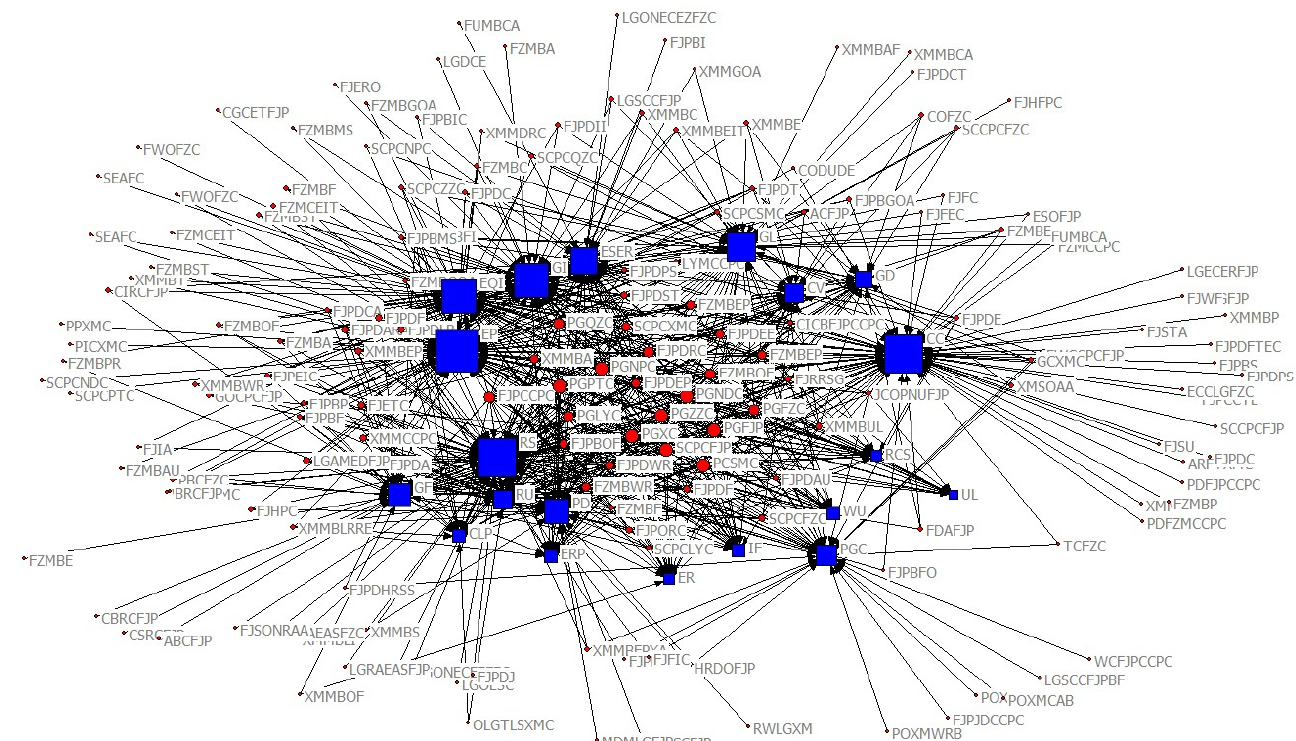
Figure 2. Overall organization-functional network (Phases I to III). Table 2. Normal degree centrality of policy goals.